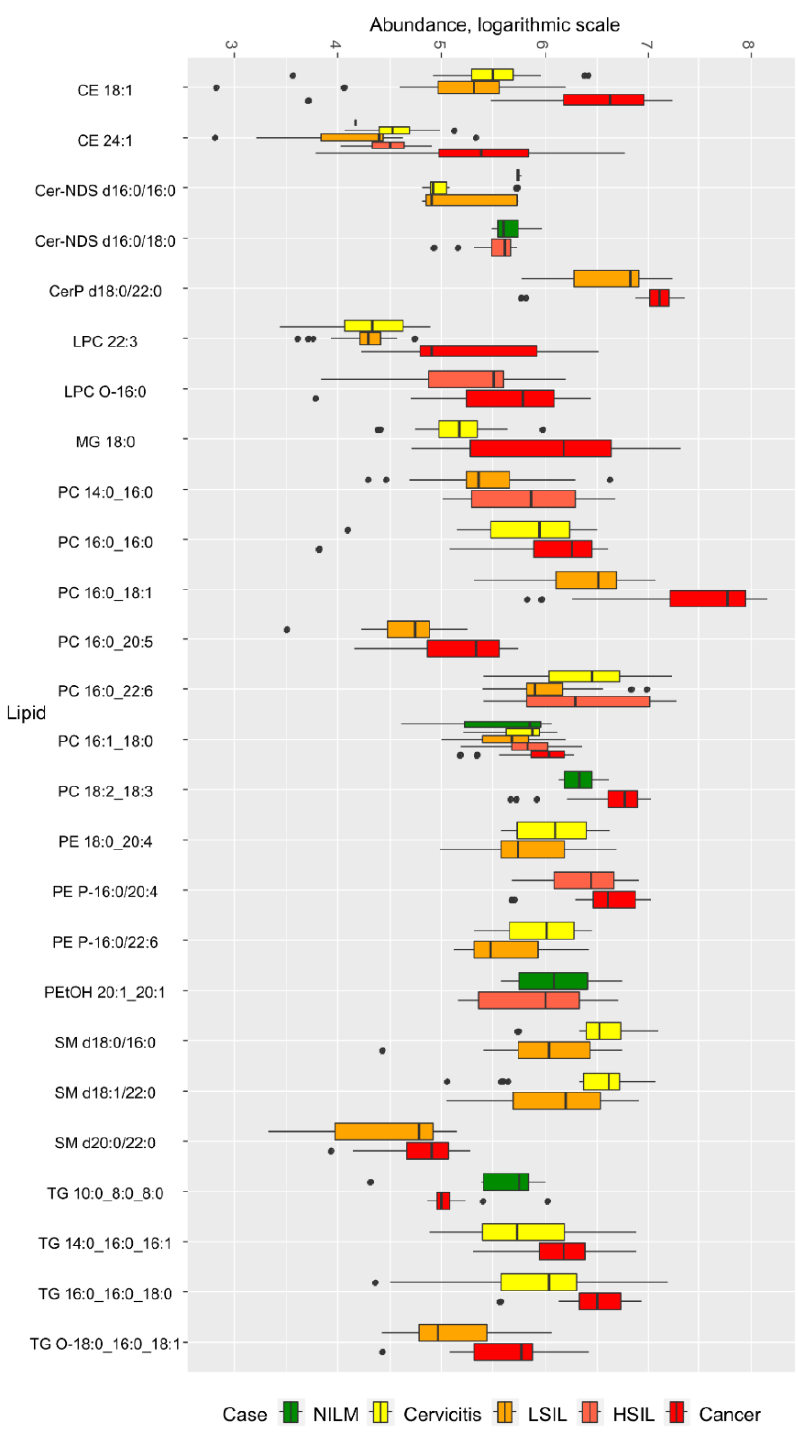
Figure 2. Box plot of lipid levels detected in positive ion mode and included in the discriminative